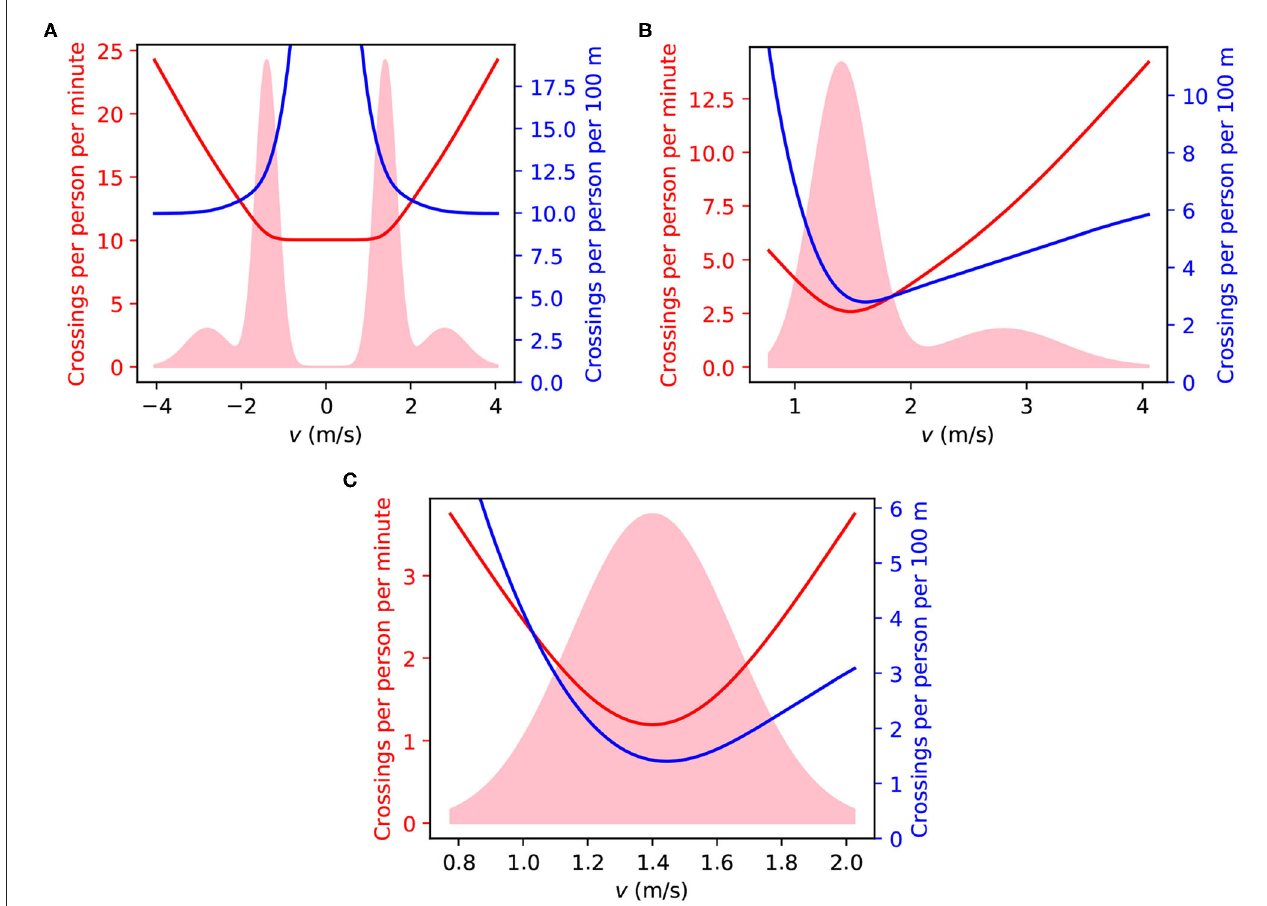
FIGURE 2 | (A) Analysis of a track with 100 people per kilometer, 80% of them walking and 20% of them running, in both directions. The speed distribution is shown as the pink area in arbitrary units. The red curve is the average number of encounters per minute for people moving at a certain speed, given by Equation (2). The blue curve is the average number of encounters per 100 m for people moving at a certain speed, given by Equation (5). (B) Same as (A) , with one-way enforced. (C) Same as (A) with one-way enforced and running forbidden. For illustration, Videos 2–4, representing 50 people in a 5,000 m track under the same rules can be found in the Supplementary Material